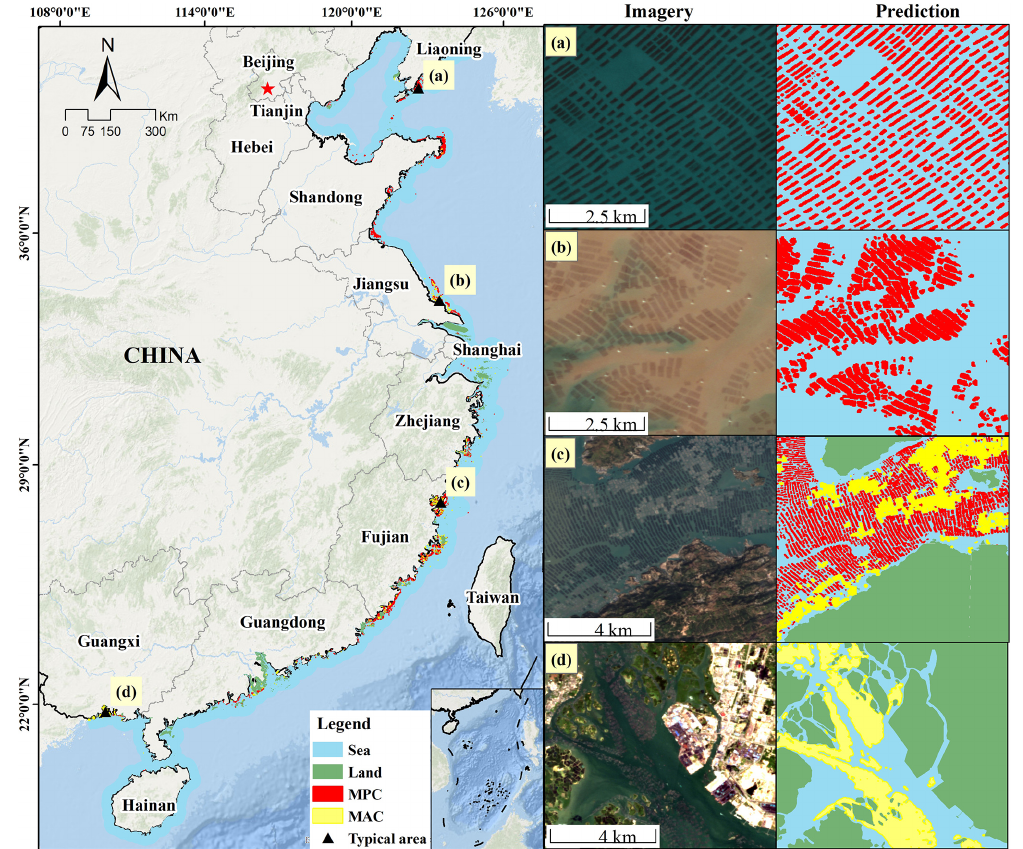
Figure 5. Spatial distribution of China’s marine aquaculture and zoom views of imagery and prediction results for typical areas of (a) , (b) , (c) , and (d)